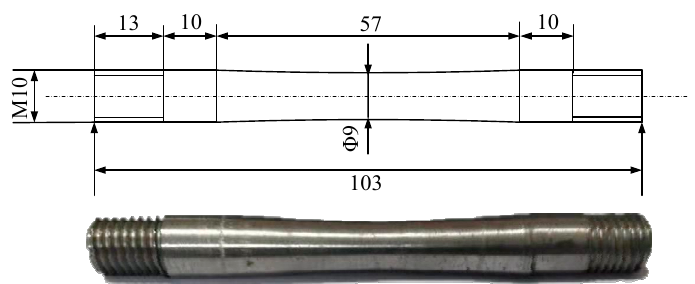
Figure 2. Schematic drawing of specimens for tensile tests (unit: mm).